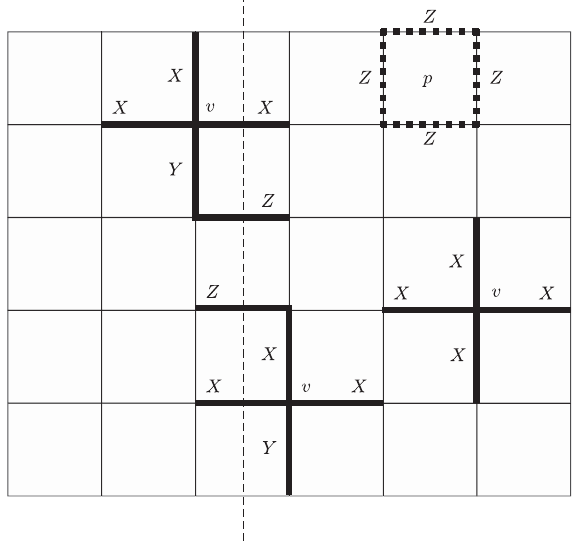
FIG. 5. Operators in the modified toric code model at the surface of the Z 2 root state. Three vertex operators A v are shown, with two adjacent to the reflection axis (dashed line) and one away from it. Each operator is a product of Pauli spin operators on the edges marked by thick solid lines, with X , Y , Z corresponding to τ x , τ y , τ z . Plaquette operators B p are products of four τ z operators around the perimeter of a plaquette p , as indicated by thick dotted lines.